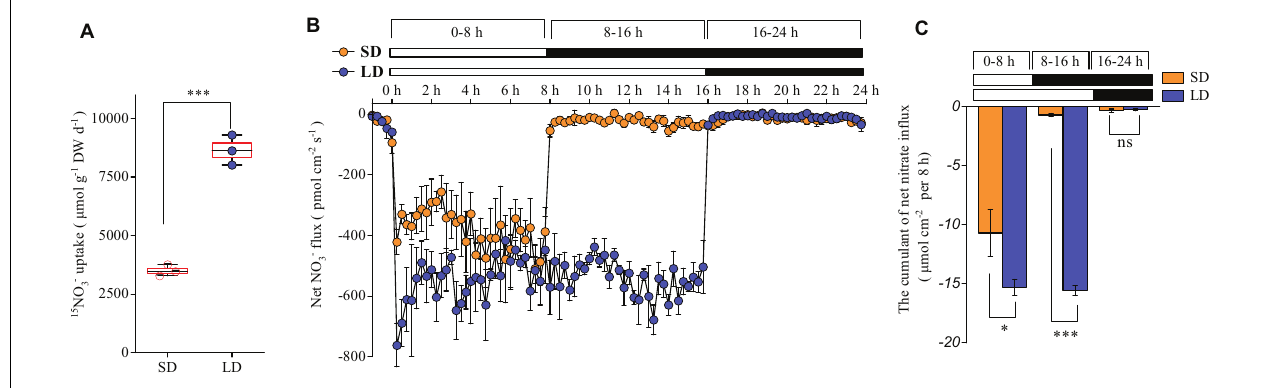
FIGURE 3 | LD photoperiod treatment increases the root nitrate uptake. Nitrate (1 mM) was used as the exclusive N source in this experiment. (A) Daily nitrate uptake of the roots in LD (16-h light/8-h dark) or SD (8-h light/16-h dark) conditions. Col-0 plants were grown hydroponically for 2 weeks before being harvested for the measurement of 15 NO 3 - uptake. Error bars represent ± standard deviations ( n = 3) of four biological replicates. (B) Dynamic changes in the net NO 3 - flux in the roots of Col-0 plants grown under LD or SD conditions. Bars above the graph indicate the duration of day (white) and night (black). Seedlings (at the stage when four leaves were visible) grown in agar medium were used to measure the net nitrate fluxes in the maturation zones. Each data point represents the average of the net nitrate flux over 15 min. Negative symbols indicate net influx; error bars represent means ± standard deviations ( n = 4). (C) The cumulated net nitrate influx calculated for each 8-h period in the roots of the Col-0 plants grown under the LD or SD conditions. The value of each period (0–8 h, 8–16 h, or 16–24 h) was calculated according to the corresponding period in (B) . Asterisks indicate significant differences between treatments ( ∗ P < 0.05, ∗∗∗ P < 0.001; one-way ANOVA with Tukey’s multiple comparisons